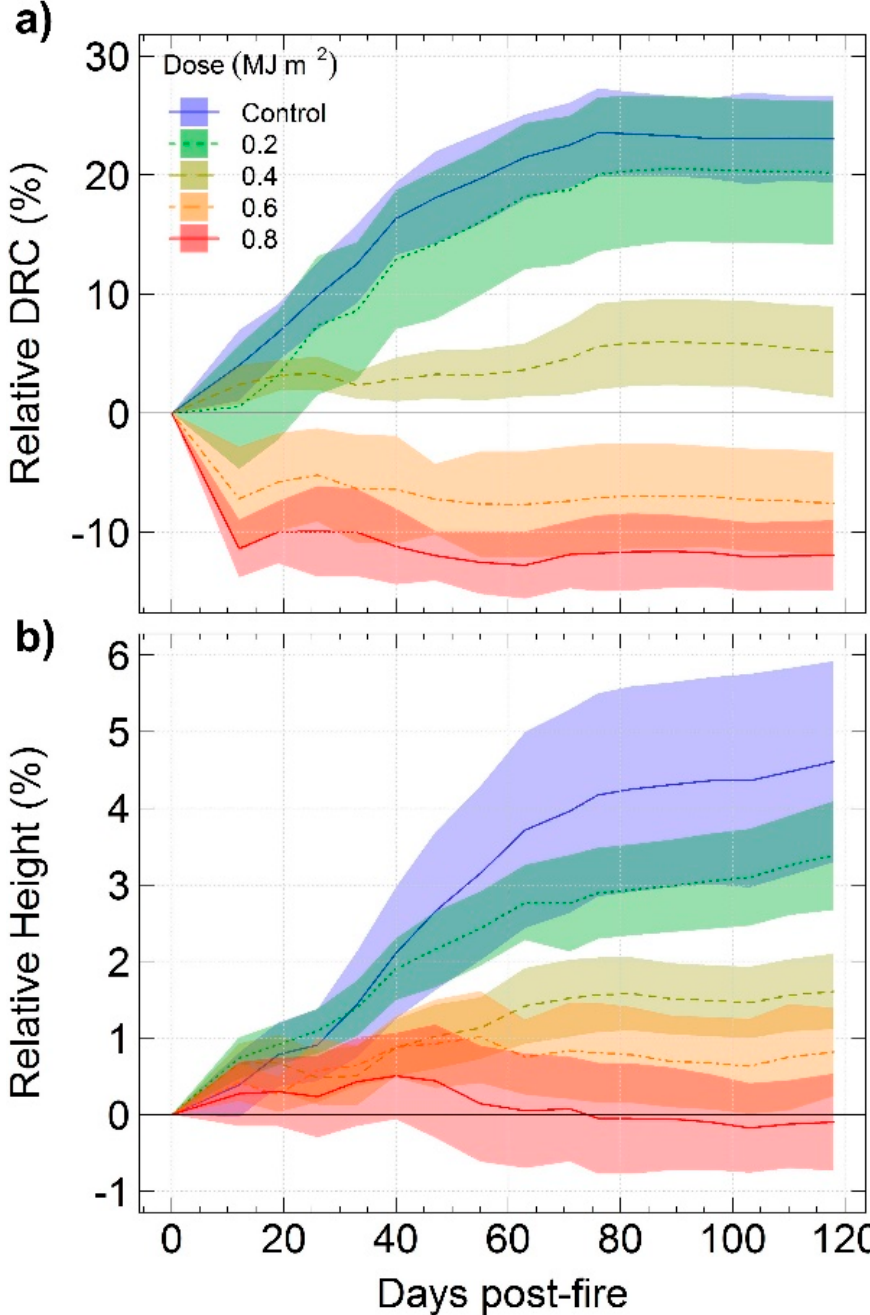
Figure 4. Relative changes in post-fire sapling growth for each treatment group (L = 5, r = 10) for up to 120 days post-fire. ( a ) Relative changes in diameter at root collar (DRC). ( b ) Relative changes in sapling heights. The colored bands depict the 95% confidence interval for each treatment group. The lines represent the average values of the post-fire percentage changes for each group of replicates (r = 10), where the colored bands represent the 95% confidence interval.